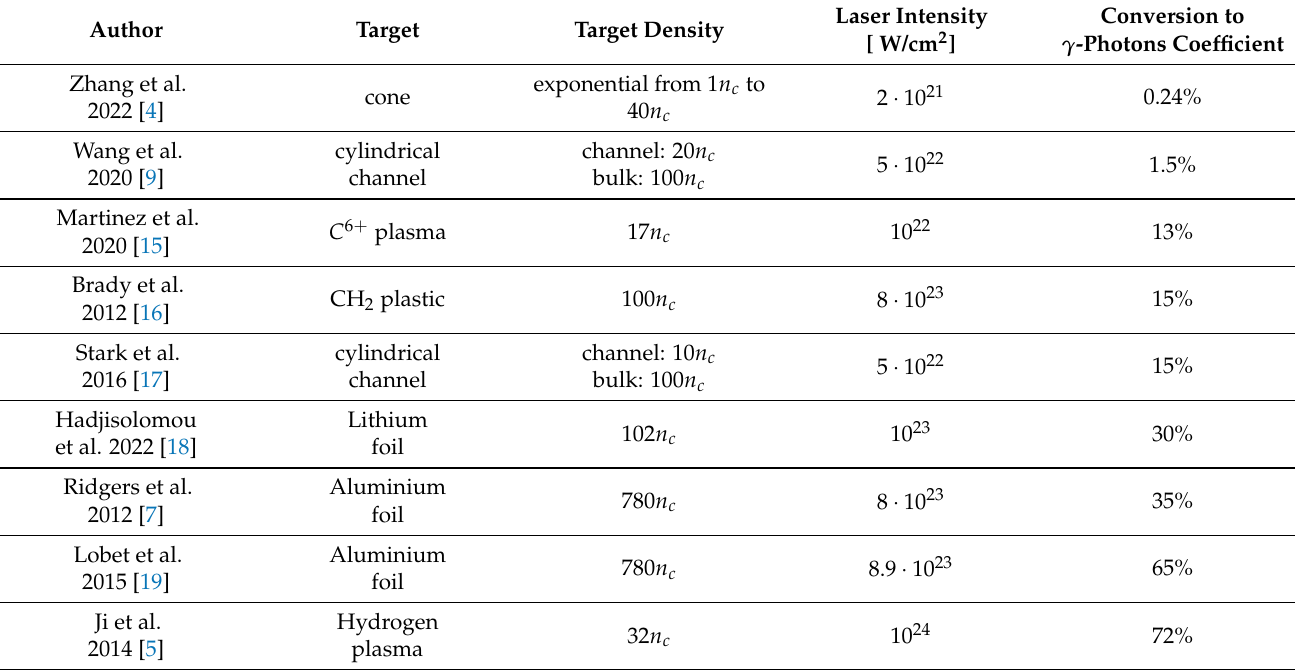
Table 1. Conversion coefficient of the laser energy to high energy γ -photons as obtained in theoretical and numerical studies of laser–plasma